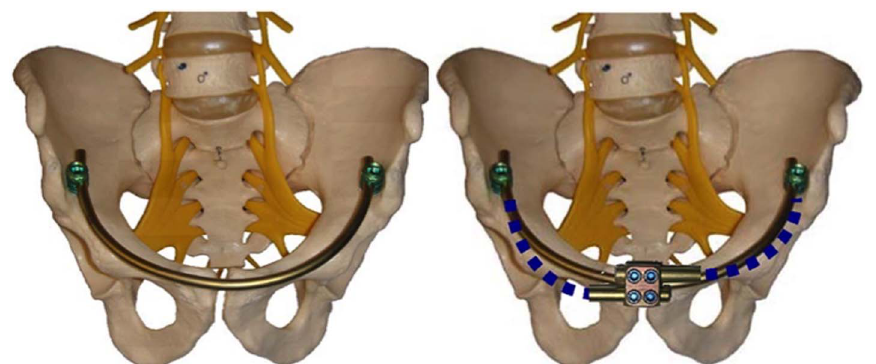
Figure 2. “ INFIX ” Vaidya